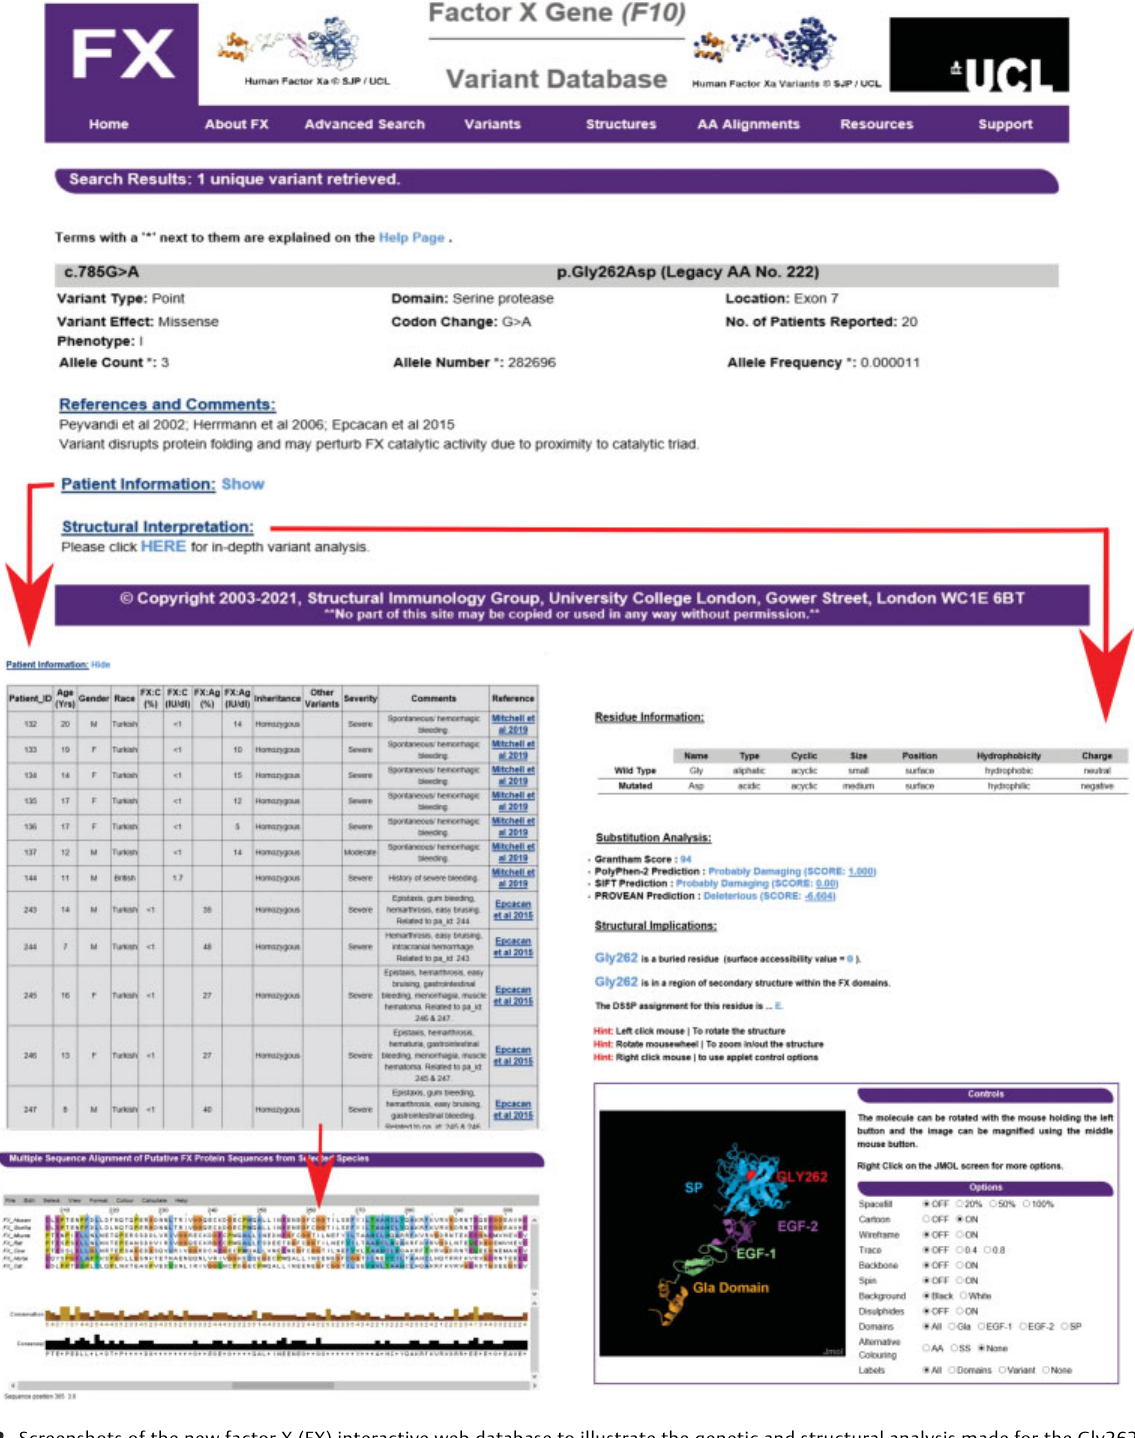
TH Open Vol. 5 No. 4/2021 © 2022. The